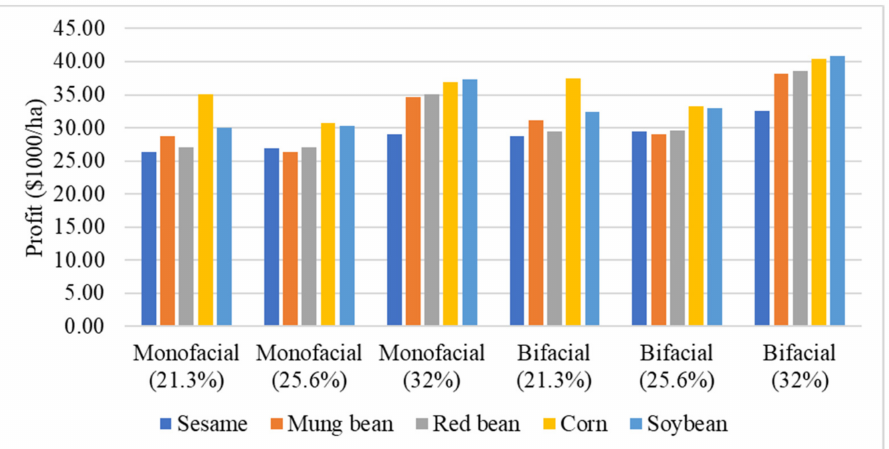
Figure 6. Estimated profits of the five crops grown under the six APV types (SMP and REC